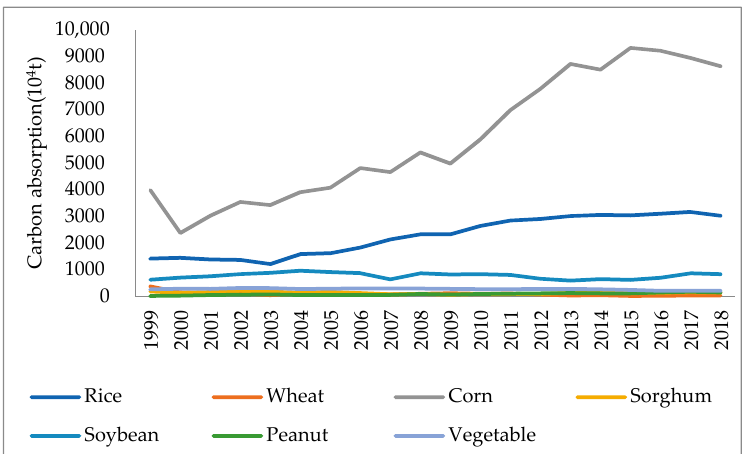
Figure 1. Crop composition of carbon absorption by planting industry. Data Source: calculated by the authors.